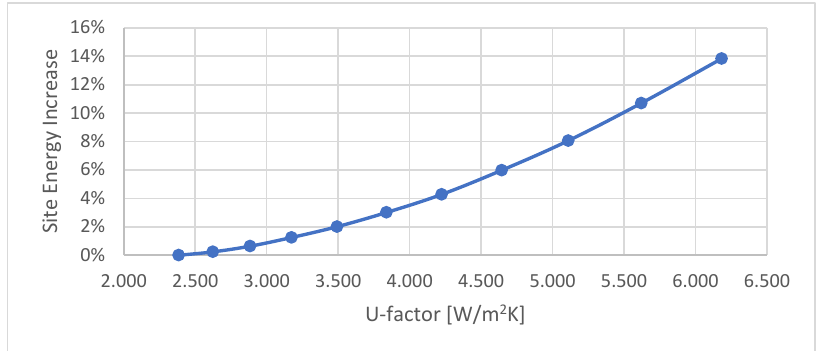
Figure 29. Site Energy Increase as a Function of Window U-factor.